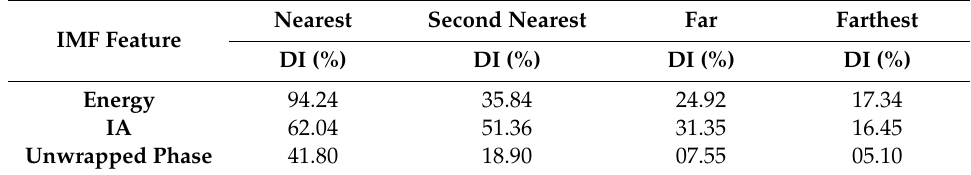
Figure 15. Comparison of the IMFs’ unwrapped phase outputs of the acceleration responses by the proposed model for different sensor locations from the damaged element. Table 2. Damage index results based on the IMF features for different sensor locations from the damaged element.